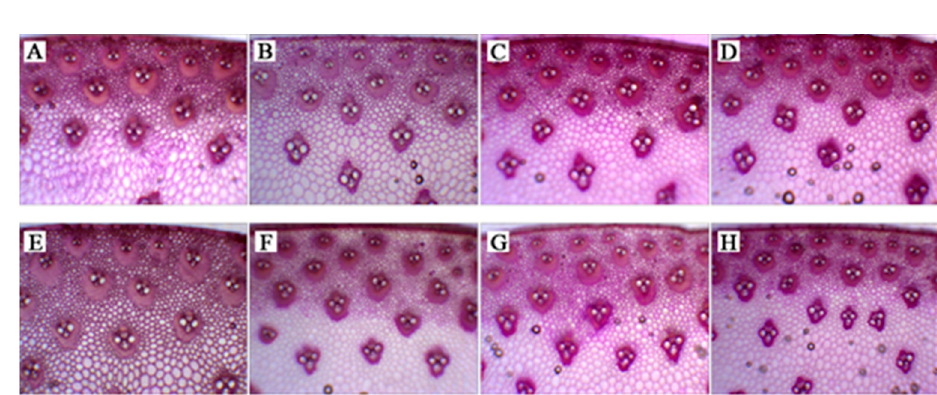
ns ns ns ns ns (1) Values followed by a different small letter within a column are significantly different at 5% probability level. Differences between treatments were calculated within the hybrids. (2) * and ** indicate significant differences different at the 0.05 and 0.01 probability levels, respectively. ns, not significant.